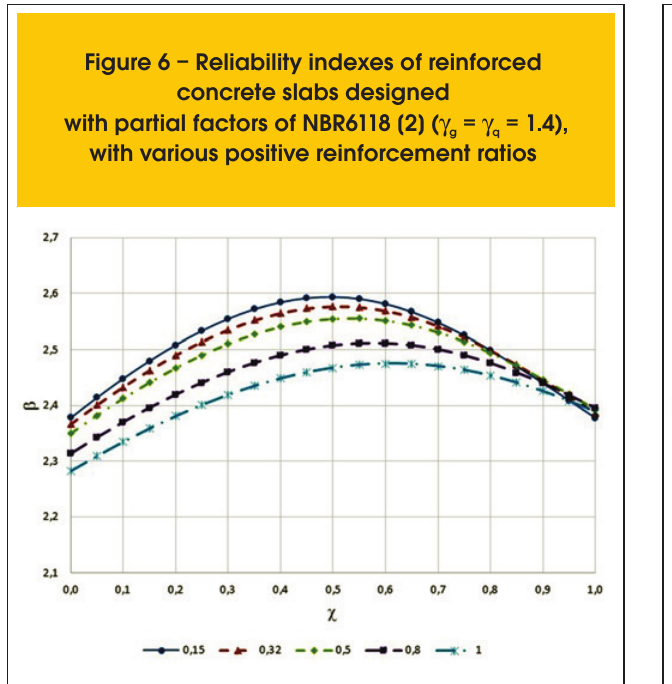
Figure 6 – Reliability indexes of reinforced concrete slabs designed